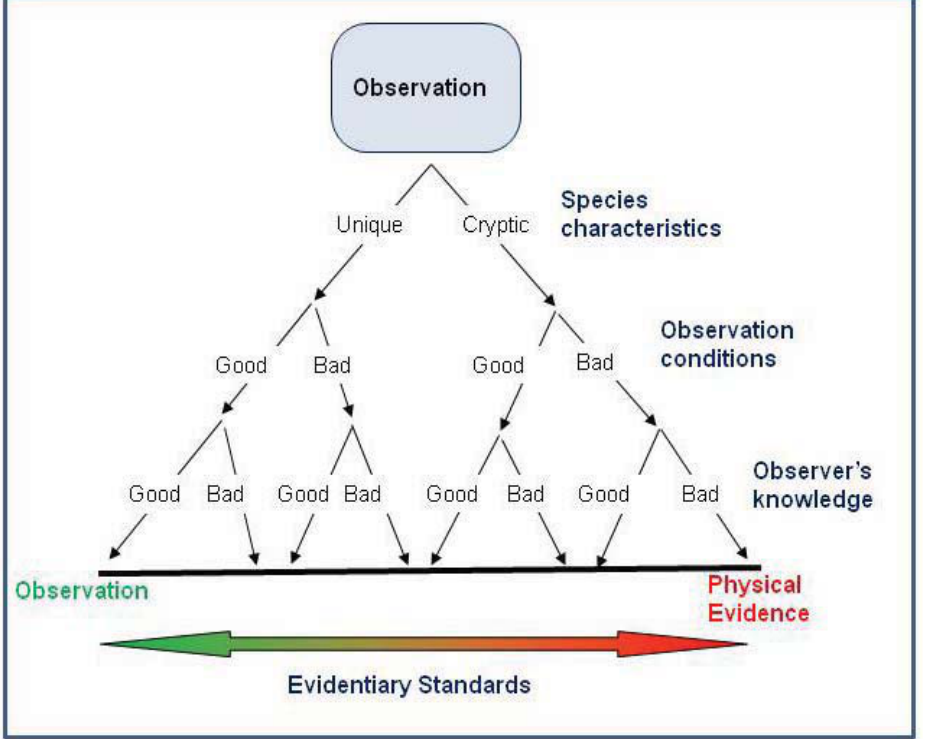
Figure 5. Scheme of evidentiary standards for occurrence records based on the species characteristics, observation conditions, and observer’s knowledge. The highest evidentiary standards ( i.e. , requiring physical evidence) are necessary when the species poses identification problems or when observation conditions or the observer’s knowledge are poor. In contrast, anecdotal evidence might be acceptable for interpreting distribution if the species has readily observable diagnostic features, especially if observation conditions allow evaluation of the diagnostic features, or the observation is made by a taxon